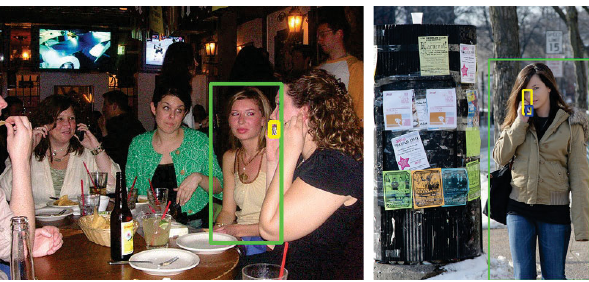
Fig. 6 Failures. Left: human and object are wrongly associated in a confusing scene. Right: the object detector incorrectly localizes the object. Yellow, blue boxes: detected, ground truth objects, respectively. Green box: detected